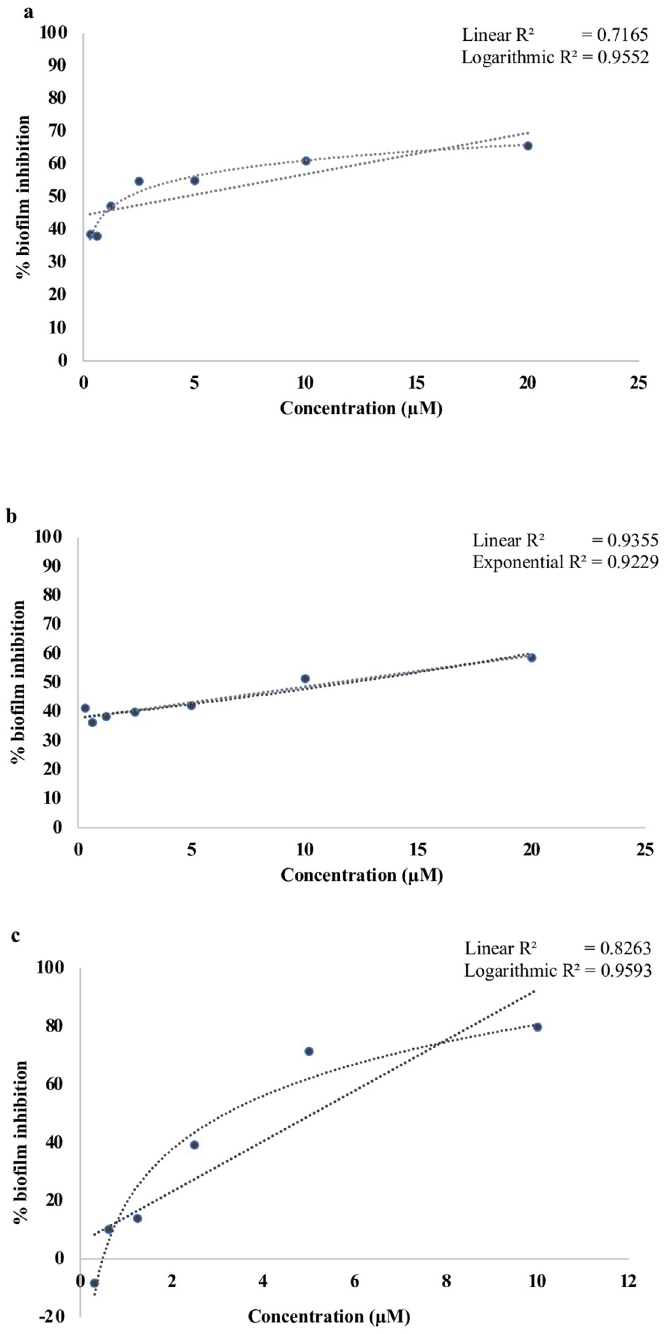
Fig 4. Regression analysis showing the relationship between percentage biofilm inhibition and drug concentrations by: a) MMV688978, (b) MMV687800, (c) MMV688990. Hits demonstrated concentration dependent biofilm inhibition and were active (meeting > 30% biofilm inhibition cut-off) at concentrations as low as 2.5 μ M.